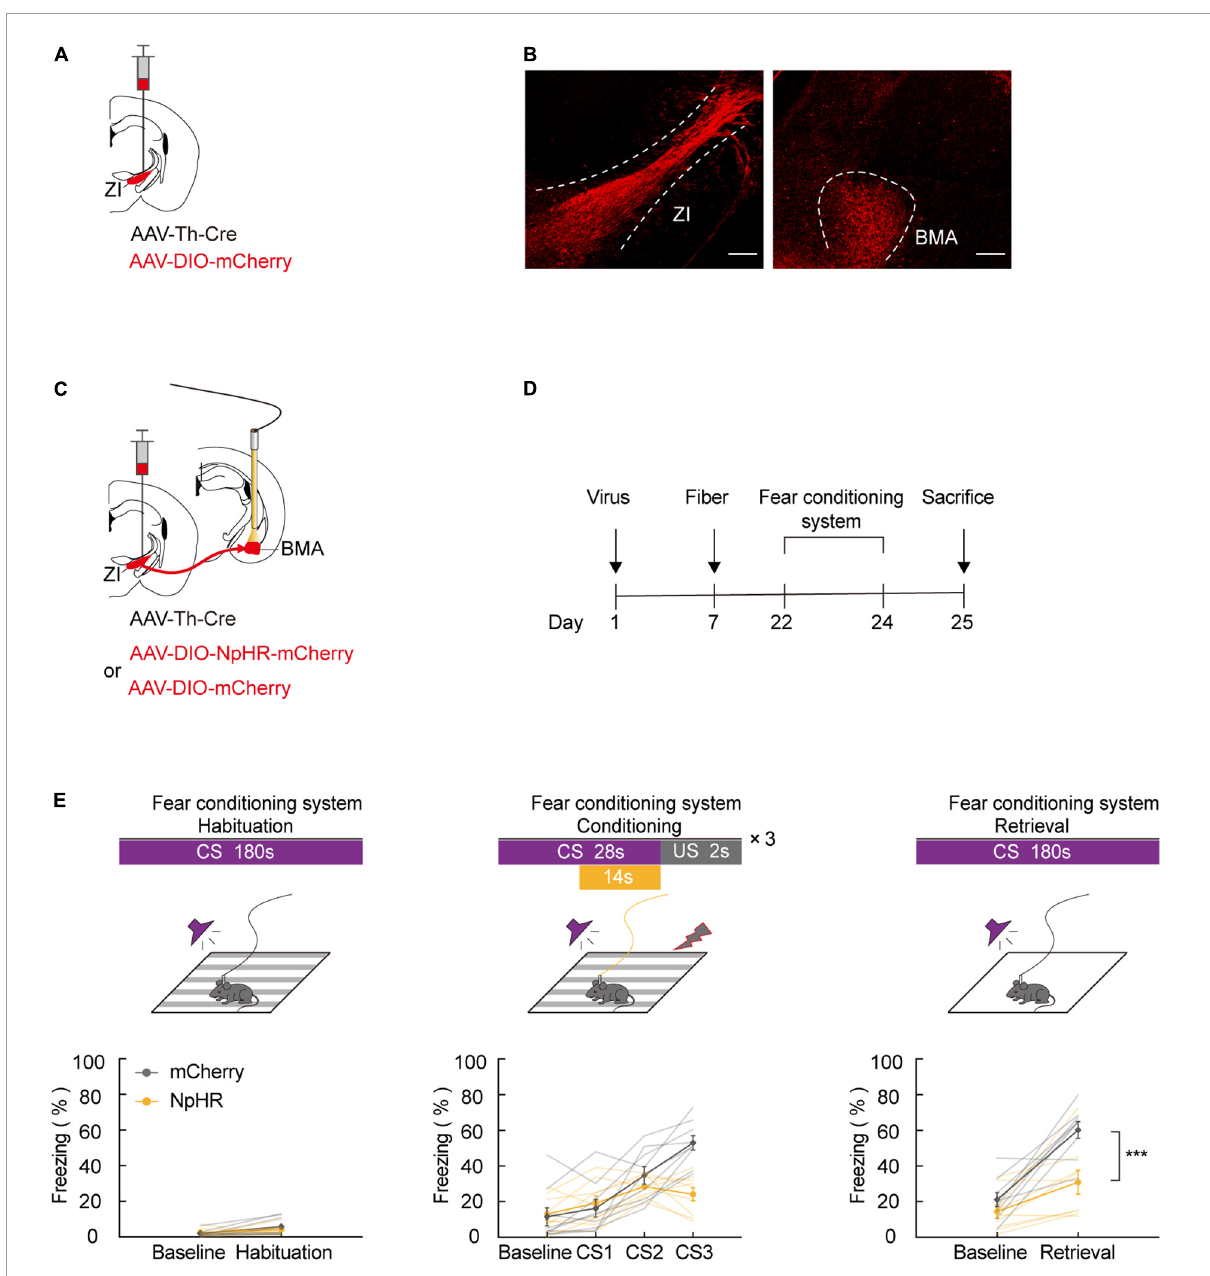
FIGURE3 ZI TH + neurons projected to BMA, and photogenetic inhibition of ZI-BMA TH + circuit blocked aversive learning. (A) Schematic representation of the virus injection. (B) Representative image of mCherry in the ZI injection site and mCherry + terminals in the BMA. Scale bar, 500 µ m. (C) Schematic representation of the virus injection and optic fiber implantation. (D) Experimental protocol timeline. (E) Behavioral paradigm of fear-conditioning system and its corresponding freezing behavior (habituation phase, two-way RM ANOVA, group: p = 0.6091, time: p = 0.0127, interaction: p = 0.2868; post hoc Sidak’s test, baseline: mCherry vs. NpHR3.0: p = 0.9341; Habituation: mCherry vs. NpHR3.0: p = 0.4705. Conditioning phase, two-way RM ANOVA, group: p = 0.1260, time: p < 0.0001, interaction: p < 0.0001; post hoc Sidak’s test, baseline: mCherry vs. NpHR3.0: p = 0.9987; CS1: mCherry vs. NpHR3.0: p = 0.9865. CS2: mCherry vs. NpHR3.0: p = 0.7015; CS3: mCherry vs. NpHR3.0: p = 0.0003. Retrieval phase, two-way RM ANOVA, group: p = 0.0035, time: p < 0.0001, interaction: p = 0.0238; post hoc Sidak’s test, baseline: mCherry vs. NpHR3.0: p = 0.5714; retrieval: mCherry vs. NpHR3.0: p = 0.0004. Mean ± SEM n = 9). ns not significant, *** P ≤ 0.001.